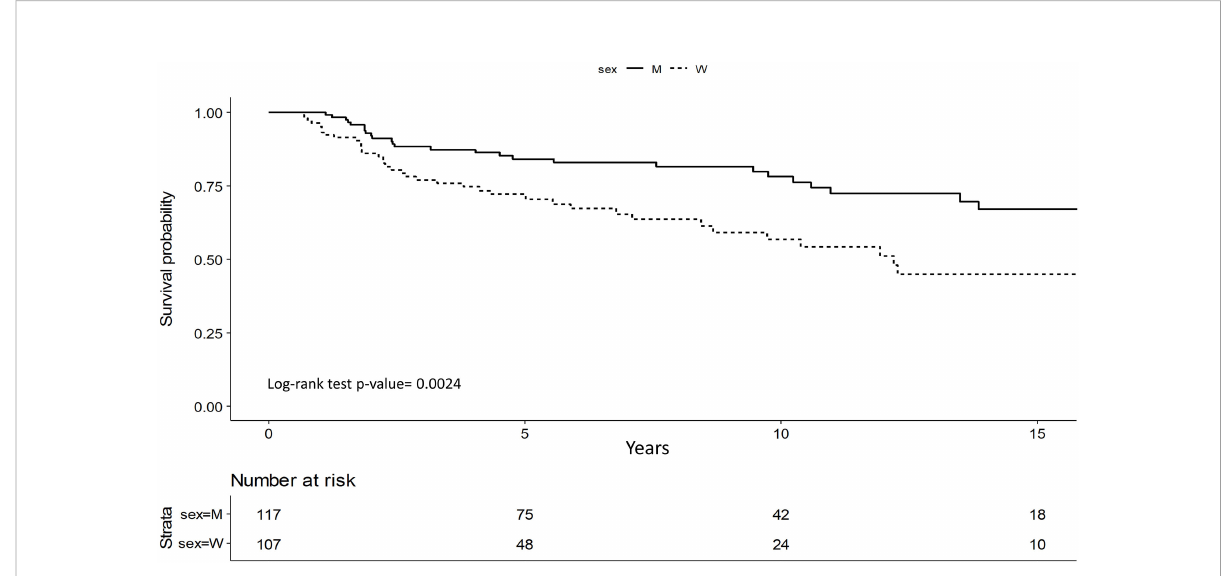
FIGURE 1 Overall Survival (OS): women vs men in stage I and